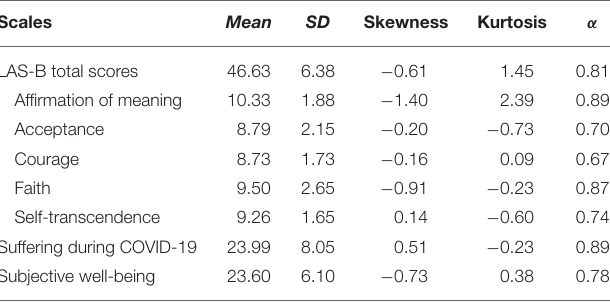
TABLE 2 | Descriptive statistics of the measure of the study.